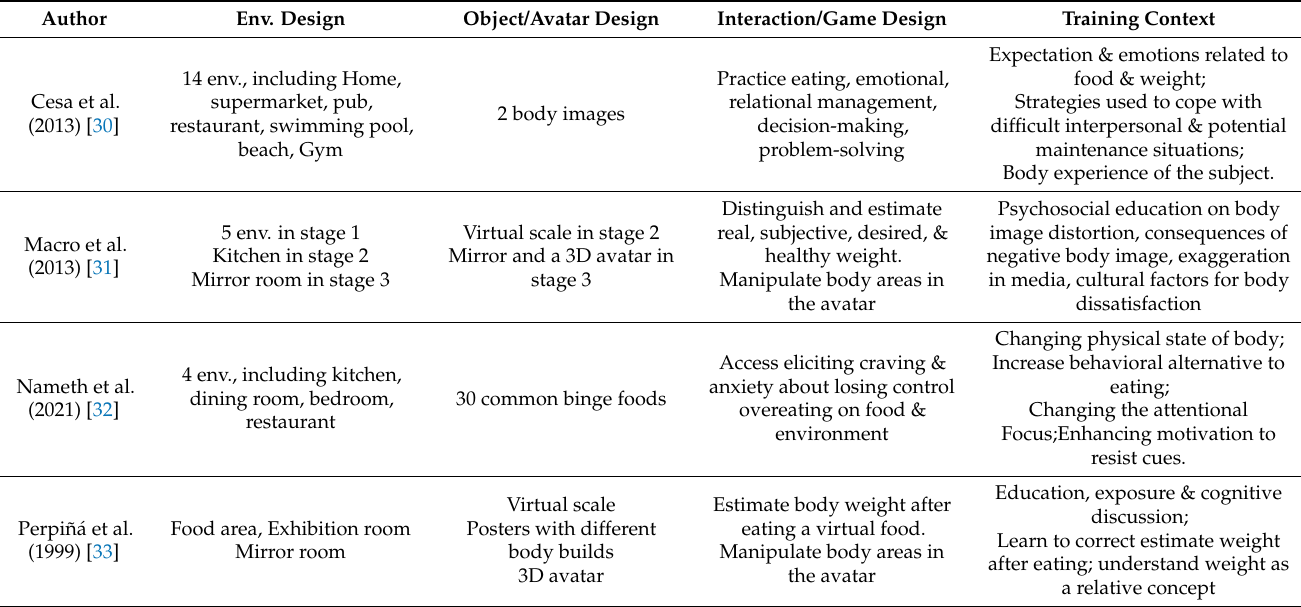
Table 4. Virtual environment and training design of the reviewed